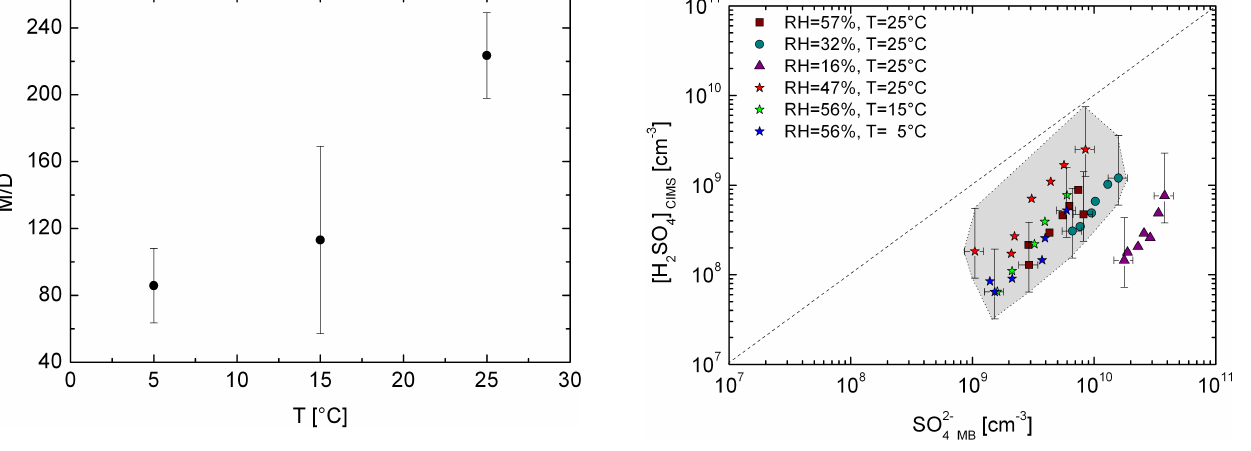
Fig. 5. The initial sulfuric acid monomer concentration determined from CIMS measurements and WLF analysis as a function of initial total sulfate concentration determined by ion chromatography (IC) analyses and subsequent mass balance calculations. The error bars stand for uncertainty in CIMS measurements (factor of two) and er- ror propagation in total sulfate mass balance calculations ( ±